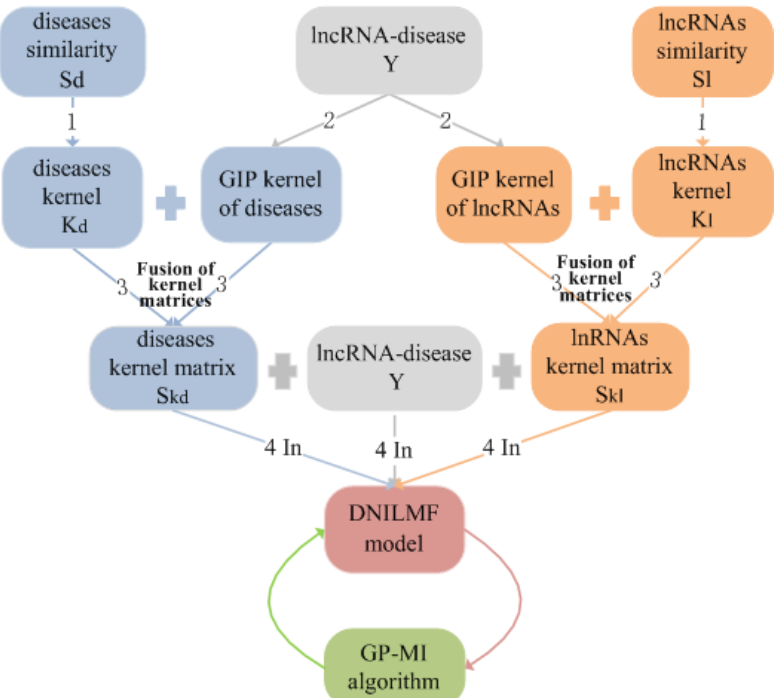
Figure 1. The flowchart of dual-network integrated logistic matrix factorization-lncRNA–disease association (DNILMF-LDA). Step 1 : converting the calculated lncRNAs’ similarity matrix and the diseases’ similarity matrix to the corresponding kernel matrix; Step 2 : calculating the Gaussian interaction profile kernel matrix of lncRNAs and diseases, respectively; Step 3 : fusing two kernel matrices corresponding to the lncRNAs and the diseases respectively into one kernel matrix; Step 4 : constructing the DNILMF model with the lncRNA–disease associations matrix, lncRNAs, and diseases kernel matrices as the input data. In order to ensure the optimal performance of the algorithm, the Gaussian process mutual information (GP-MI) algorithm is used to select parameters. GIP, Gaussian interaction